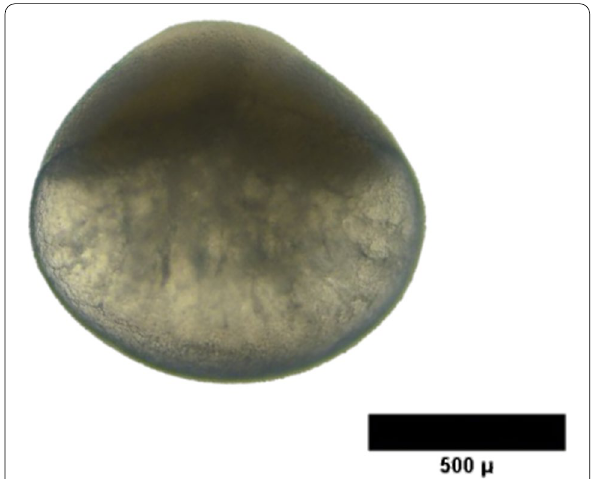
Fig. 2 Prochilodus magdalenae , zygote period, 1C: